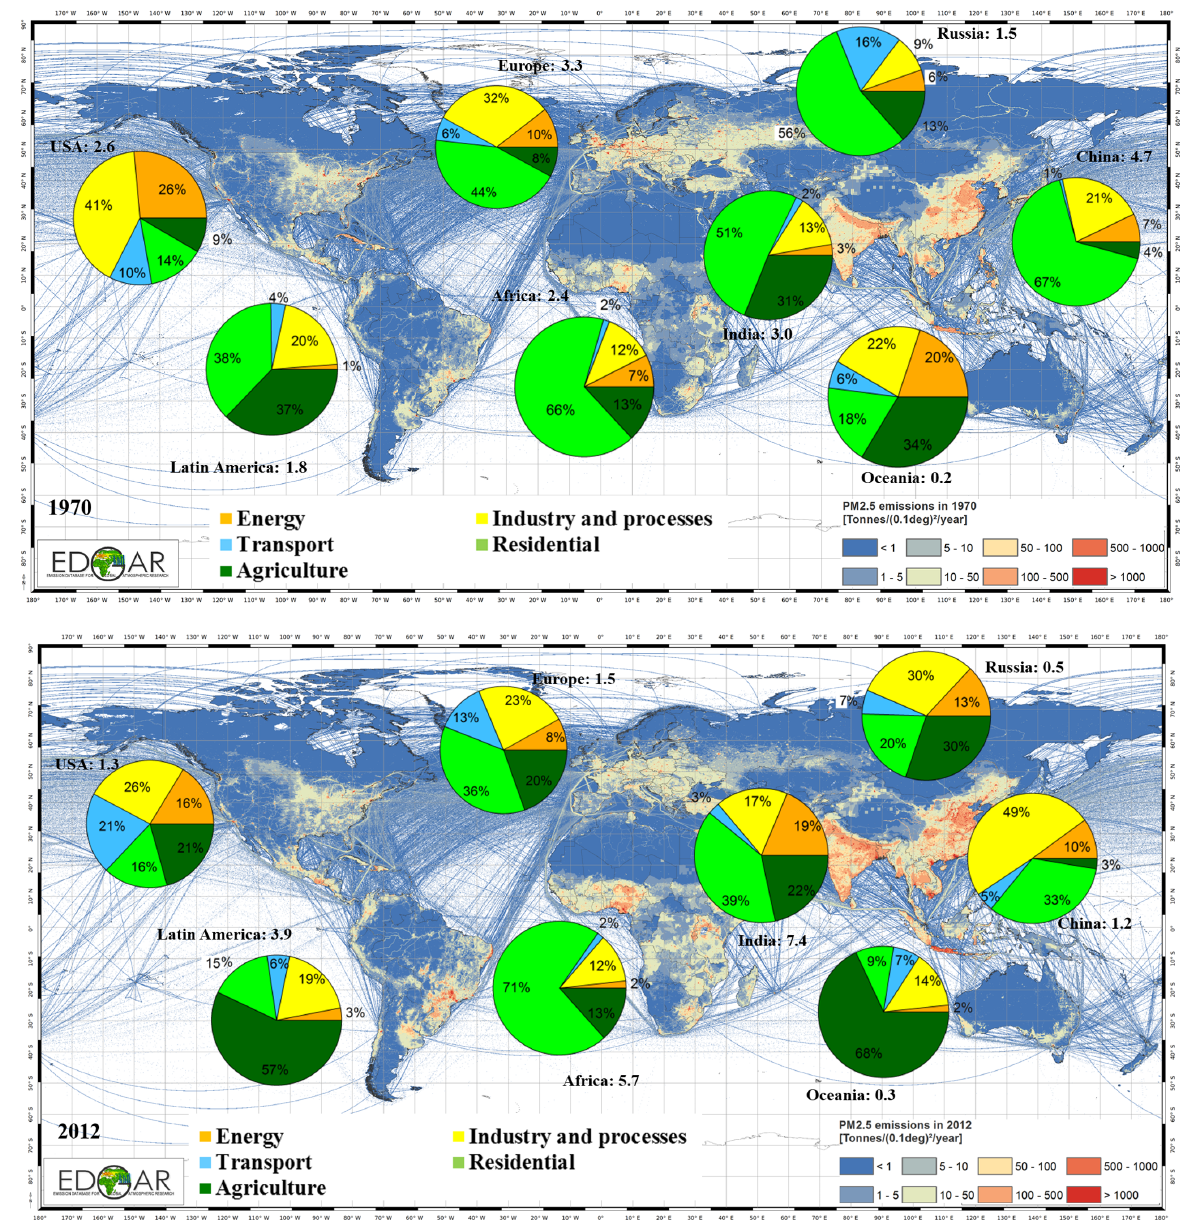
Figure 4. PM 2 . 5 emission grid maps and relative contribution of aggregated EDGAR sectors (energy, industry and processes, transport, residential, and agriculture) in world regions (pie charts) for 1970 and 2012. Total emissions (in Mtyr − 1 ) by region are also reported next to each pie